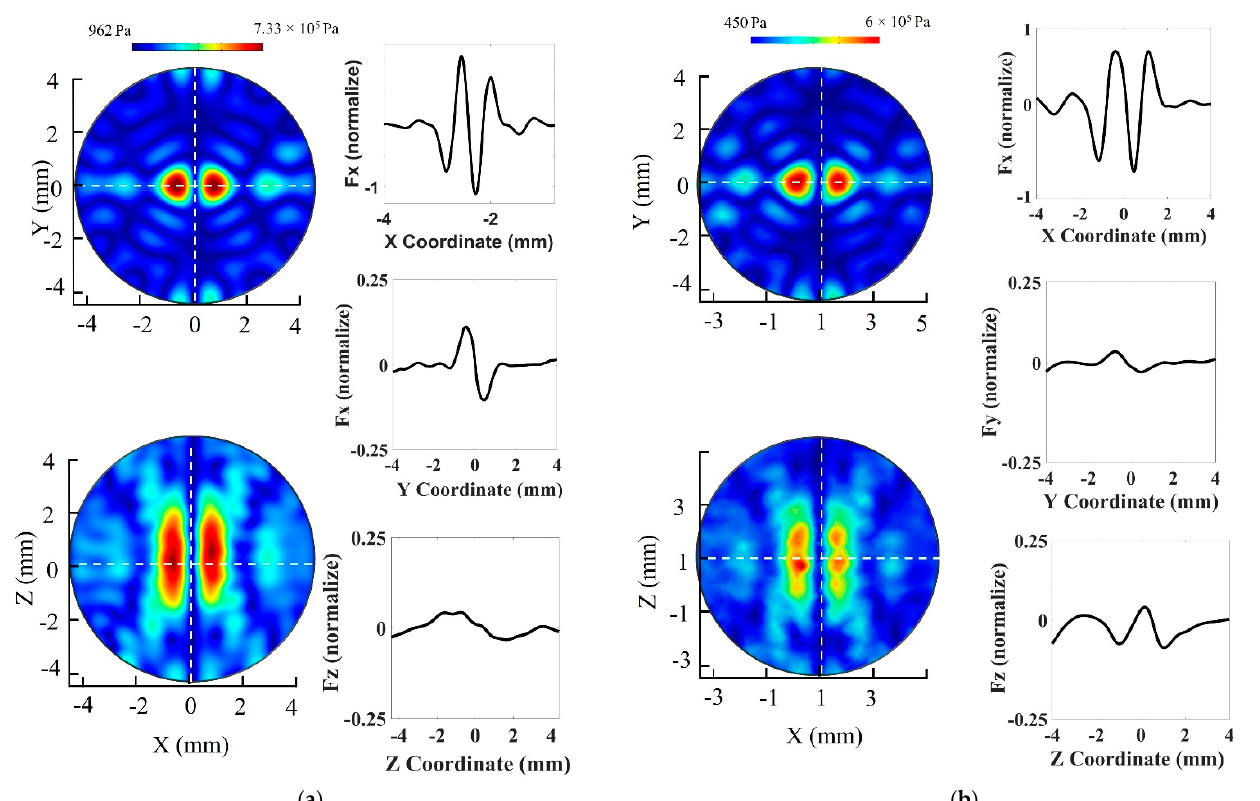
Figure 3. 3D manipulation in COMSOL Multiphysics: acoustic pressure field map and normalized acoustics radiation force at twin trap point: ( a ) (0, 0, 0); ( b ) (1, 1,